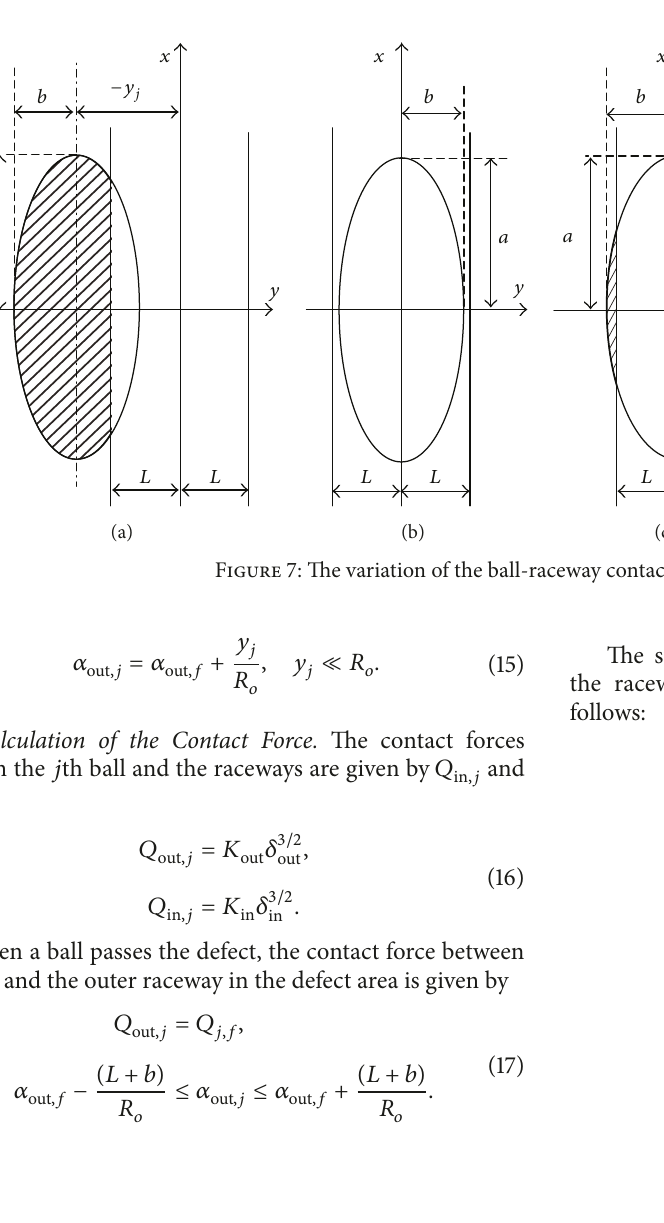
Figure 6: The ball-raceway contact area and a defect on the outer ring.